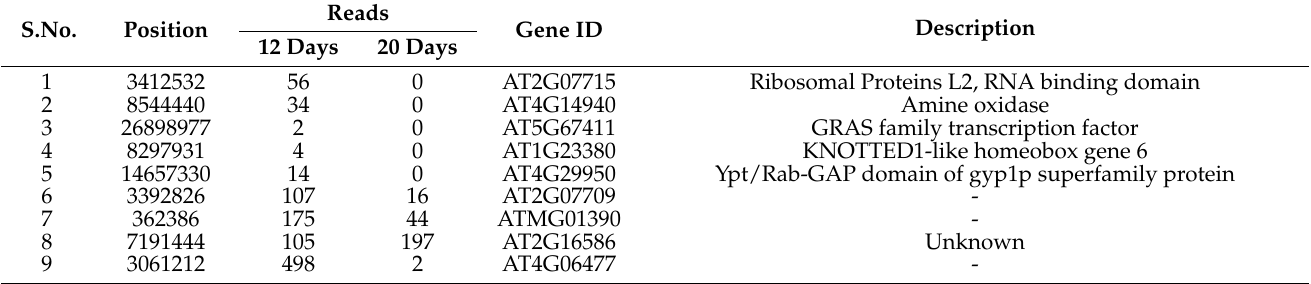
Table 1. List of candidate U-to-C RNA editing sites detected in Arabidopsis seedlings at different developmental stages.